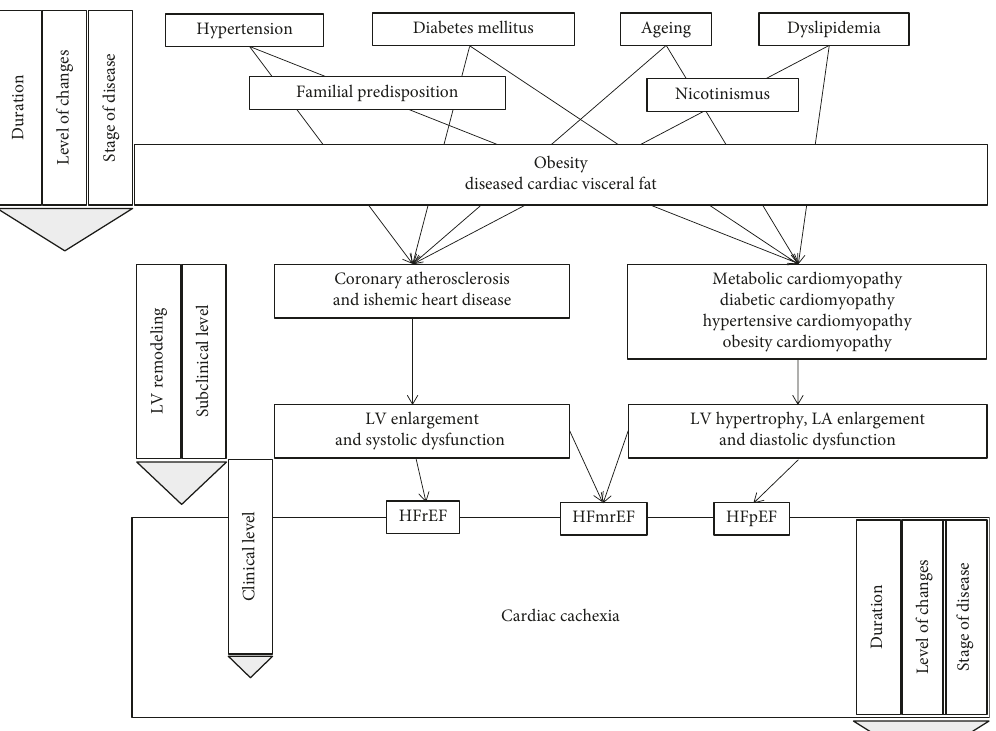
Figure 1: Algorithm of pathophysiological changes of obesity-related heart failure and consequence cardiac cachexia development, from subclinical/predisease level to clinical manifest disease. LA: left atrium; LV: left ventricle; HFrEF: heart failure with reduced ejection fraction; HFmrEF: heart failure with midrange ejection fraction; HFpEF: heart failure with preserved ejection